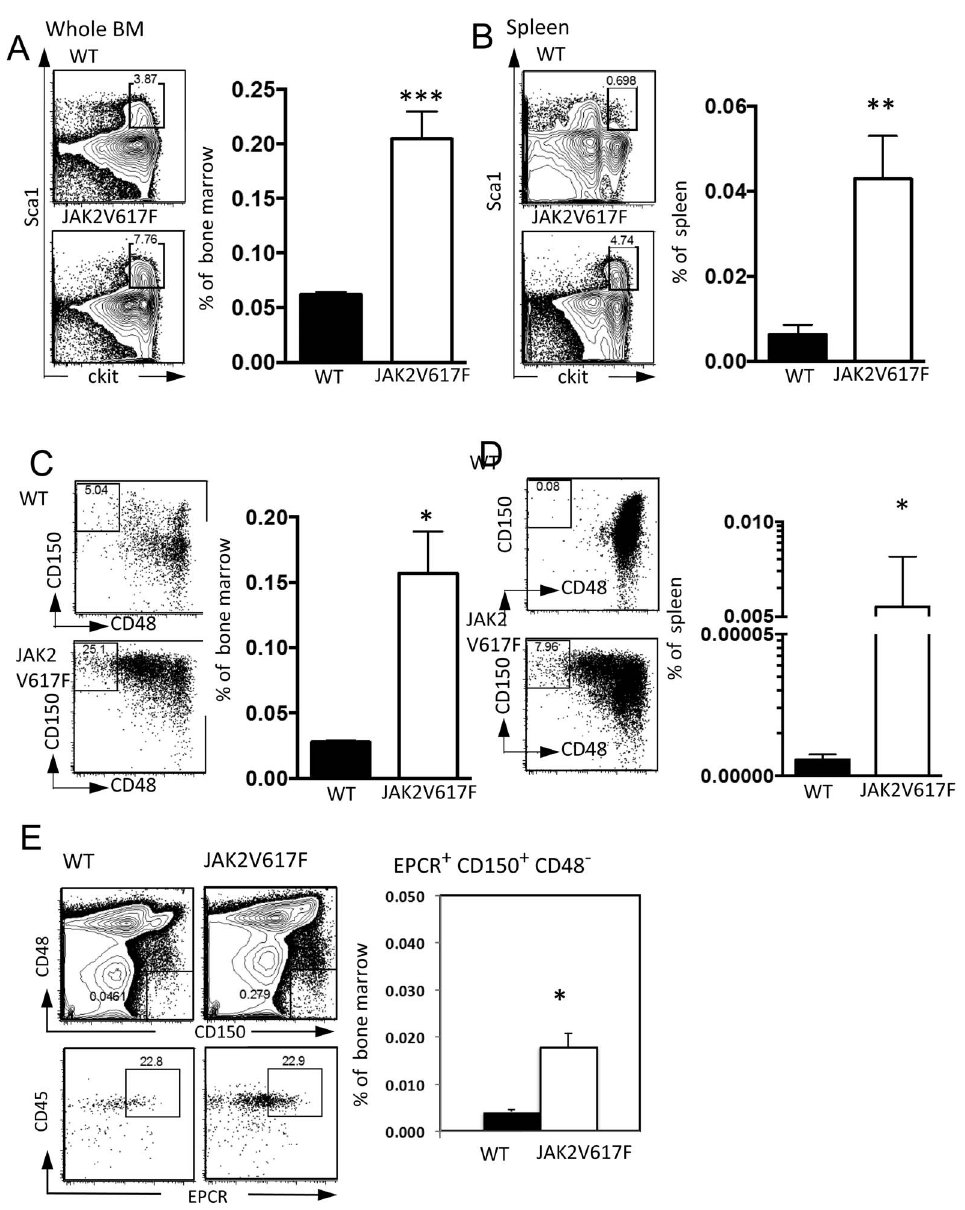
Figure 1. LSK and CD150 + CD48 2 HSCs expand in JAK2V617F Tg mice. ( A, B ) LSK were gated with c-kit and Sca-1 in BM ( A ) and spleen ( B ). The percentages of LSK are shown(right panel in A and B). CD150 + CD48 2 HSC in BM ( C ) and spleen ( D ) are given. Closed and open bars indicate WT and JAK2V617F individual mice, respectively. The data are representative of those obtained in two independent experiments (N=8, 4) ( E ) Distinct HSC were resolved as EPCR + CD45 + CD150 + and CD48 2 . The percentages of CD45 + EPCR + CD150 + CD48 2 in 10 6 BM were increased in JAK2V617F mice. The data are representative of those obtained in two independent experiments (N=6). p , 0.001(***), p , 0.01(**), p , 0.05(*).